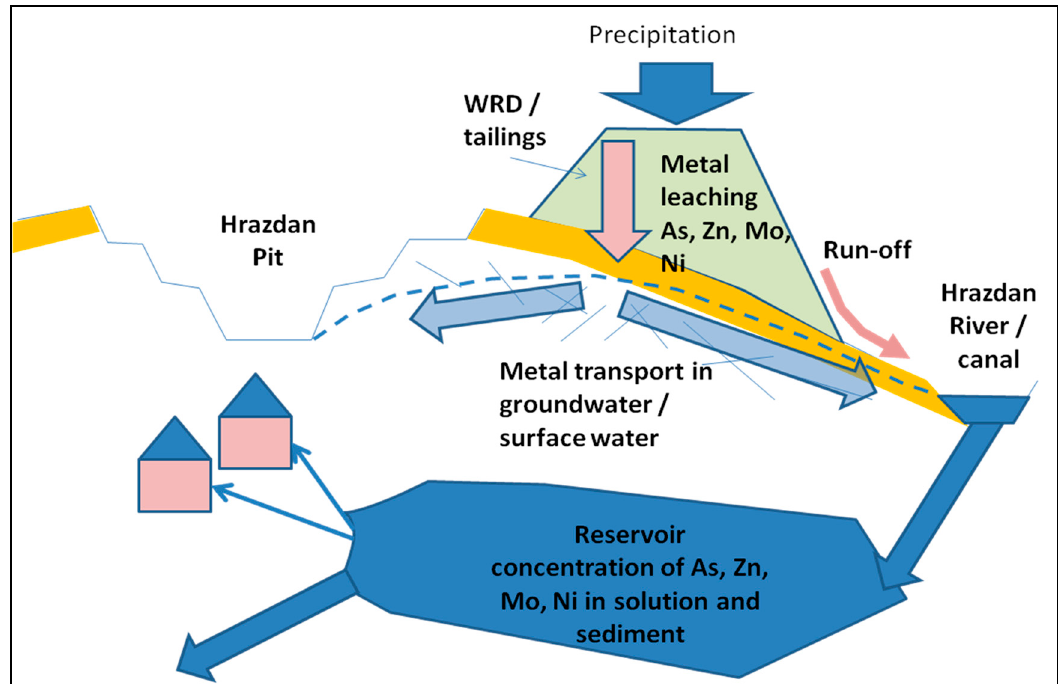
Figure 14. Geometallurgical model for arsenic leaching and acid generation within the Hrazdan waste rock. Red arrows indicate contaminated water from waste piles, blue comingled fresh and contaminated water as groundwater (light blue) or surface water (dark blue).